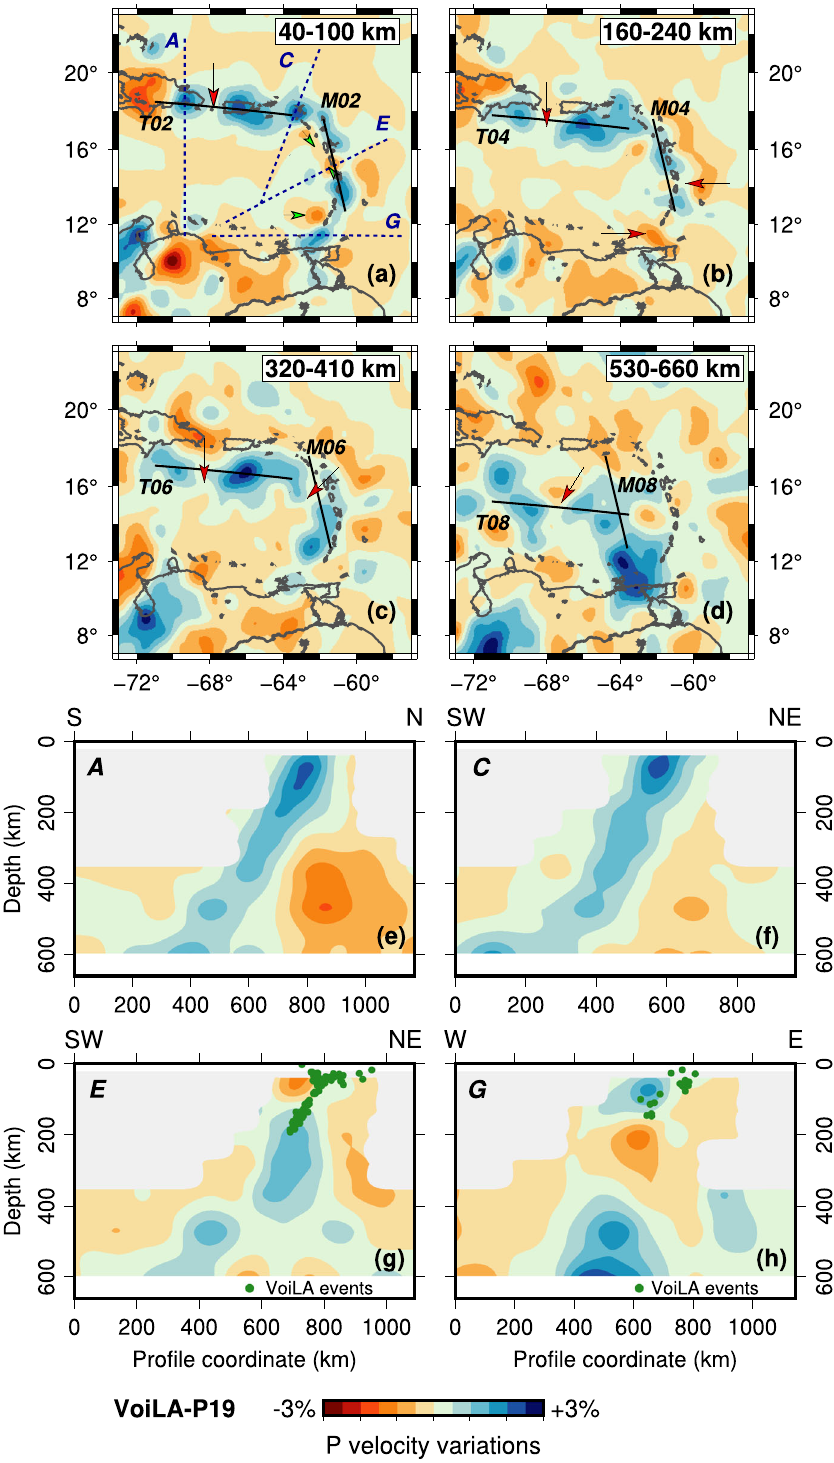
Fig. 3 Representative cross-sections through model VoiLA-P19. Velocity anomalies on this and subsequent fi gures are relative to global model AK135 67 . Plan views are shown in panel ( a ) 40 – 100 km, ( b ) 160 – 240 km, ( c ) 320 – 410 km) and ( d ) 530 – 660 km depth. Red arrows indicate the possible locations of gaps/reduced anomalies in the slab, green arrows indicate low velocities in the mantle wedge. Dark-blue dotted lines on panel ( a ) show the locations of the cross-sections shown in panels e – h ; solid black lines labelled M02 through M08 and T02 to T08 indicate the location of the dipping cross-sections in Fig. 6. In e – h , structures are masked (grey) where resolution is limited, i.e. at depths less than 300 km above and behind the slab. Seismicity shown as green dots is from the relocated VoiLA dataset 29 . e , f Pro fi les A and C show a continuous slab throughout the upper mantle below Hispaniola and the northern LAA, respectively. g The slab below St Lucia follows the seismicity, and above 100 – 150 km depth is overlain by a particularly slow mantle wedge. At about 400 km depth, there is a ~200-km lateral offset in the slab. h Cross-section G south of Grenada contains what looks like a lateral tear in the slab. Slab dip increases signi fi cantly below this tear. Further cross-sections in Supplementary Figs. 12, 13. NATURE COMMUNICATIONS| (2021) 12:4211